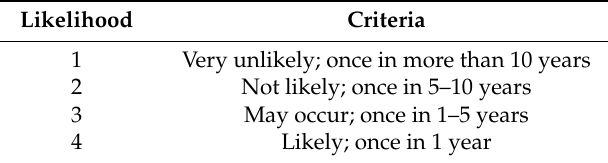
Table 2. Probability assessment.